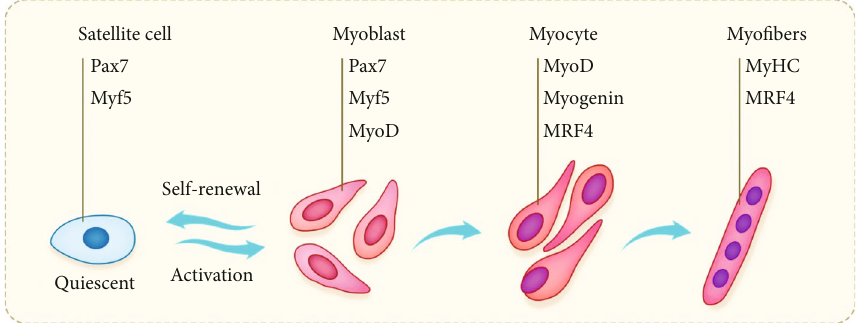
Figure 1: Schematic diagram of muscle regeneration. Skeletal muscle tissue regeneration is regulated by a genetic cascade involving Pax7 and MRFs, which drive every step of satellite cell activation, transient expansion of progenitor cells, and the di ff erentiation and formation of new muscle fi bers. Interestingly, satellite cell self-renewal can retain a small number of rested cells after regeneration to meet future regeneration